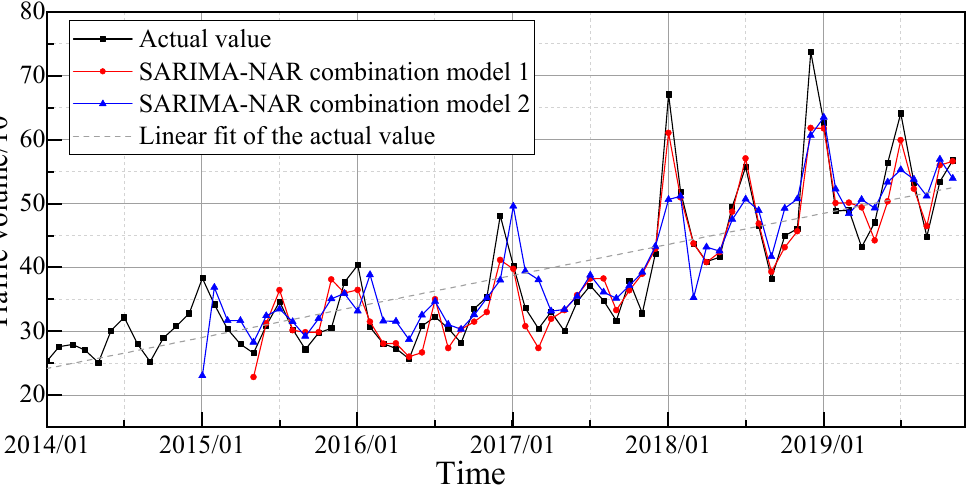
Figure 8. Prediction results of the combined model.